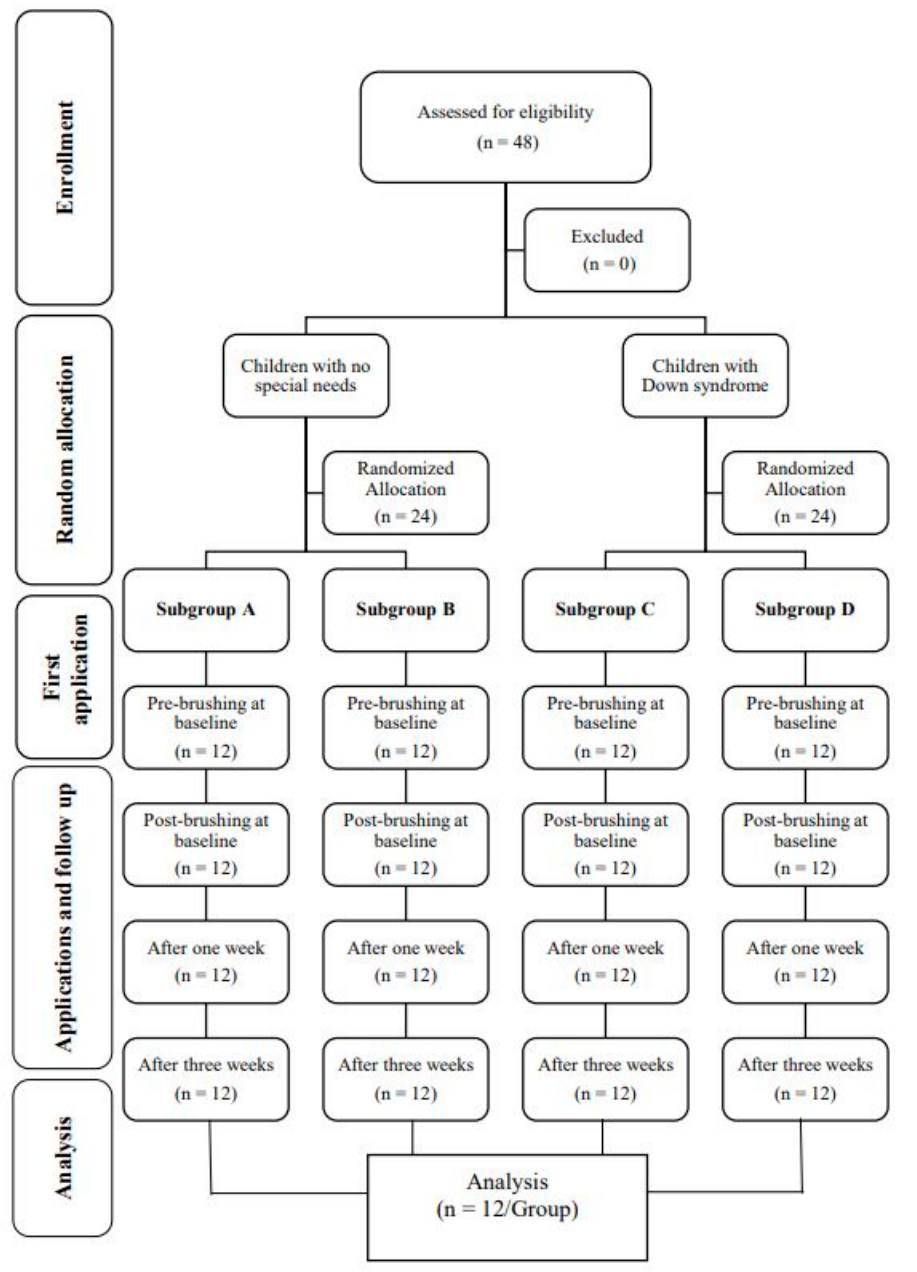
Figure 2. CONSORT flow chart of the trial during the levels of the study and follow up. Means and standard deviations of gum status for the (MGI) are represented in Table 3. Mean and standard deviations for each score of plaque accumulation at the different periods for SubA: Children with no special needs who used a conventional toothbrush; SubB: Children with no special needs who used a customized handle toothbrush; SubC: Children with Down syndrome who used a conventional toothbrush; SubD: Children with Down syndrome who used a customized handle toothbrush. Upper letters ( a–h ) indicate statistically significant differences (raw) between the different subgroups ( p < 0.05).